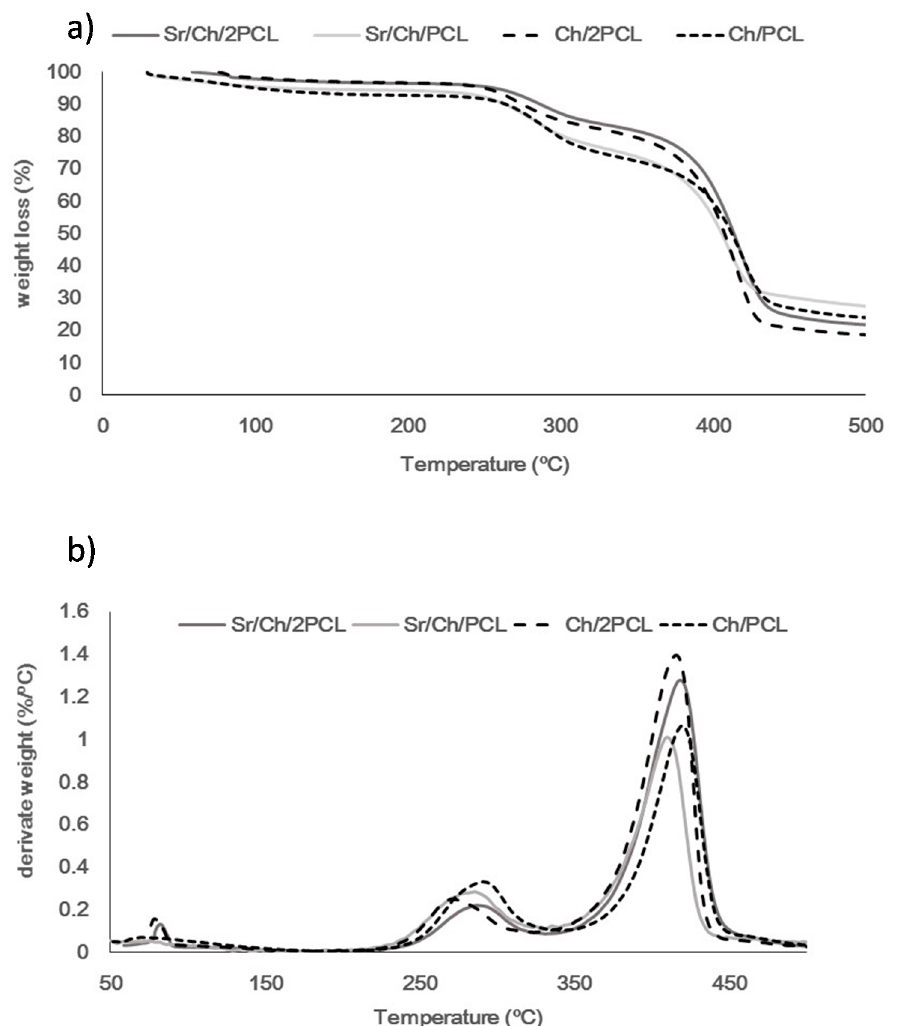
Figure 3. TGA (Termogravimetric analysis) ( a ) and DTG (Derivative Thermogravimetric analysis) curves ( b ) of blank and Sr(II) membranes under nitrogen atmosphere. Ch: chitosan; PCL: poly( ε - caprolactone).